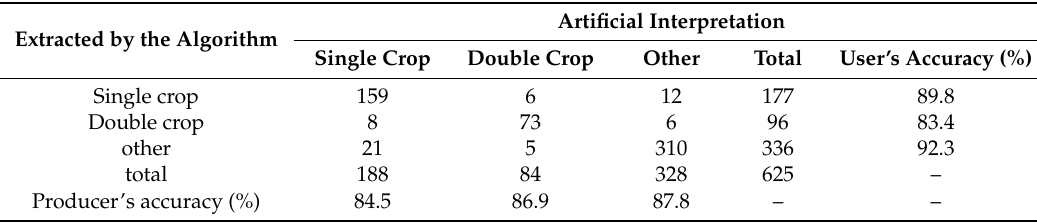
Table 1. Confusion matrix of cropping frequency map.